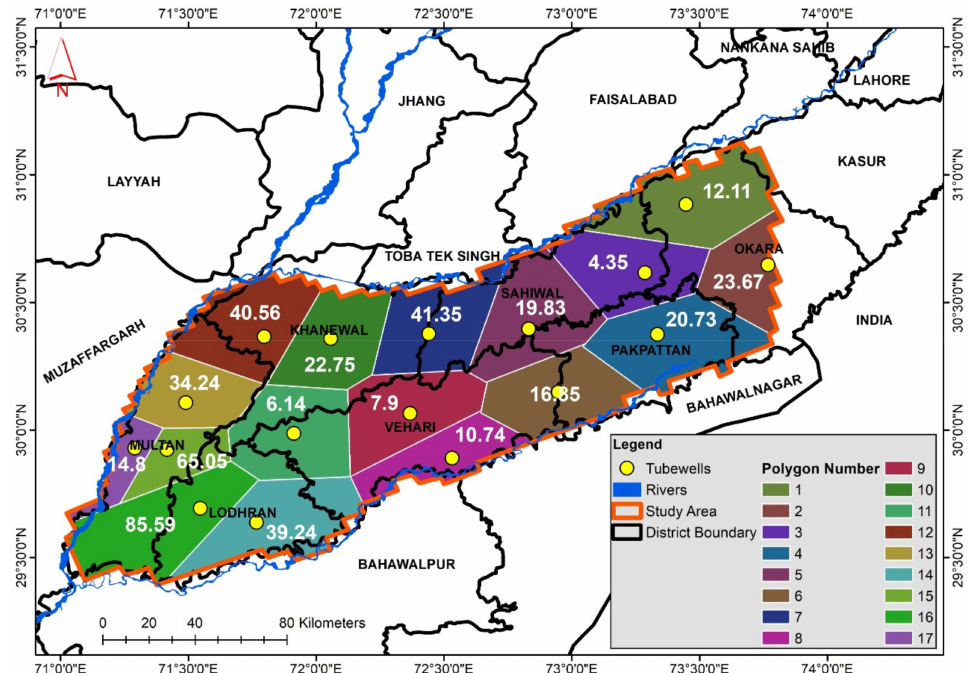
Figure 8. Distribution of final value of hydraulic conductivity K (m/day) indicated in